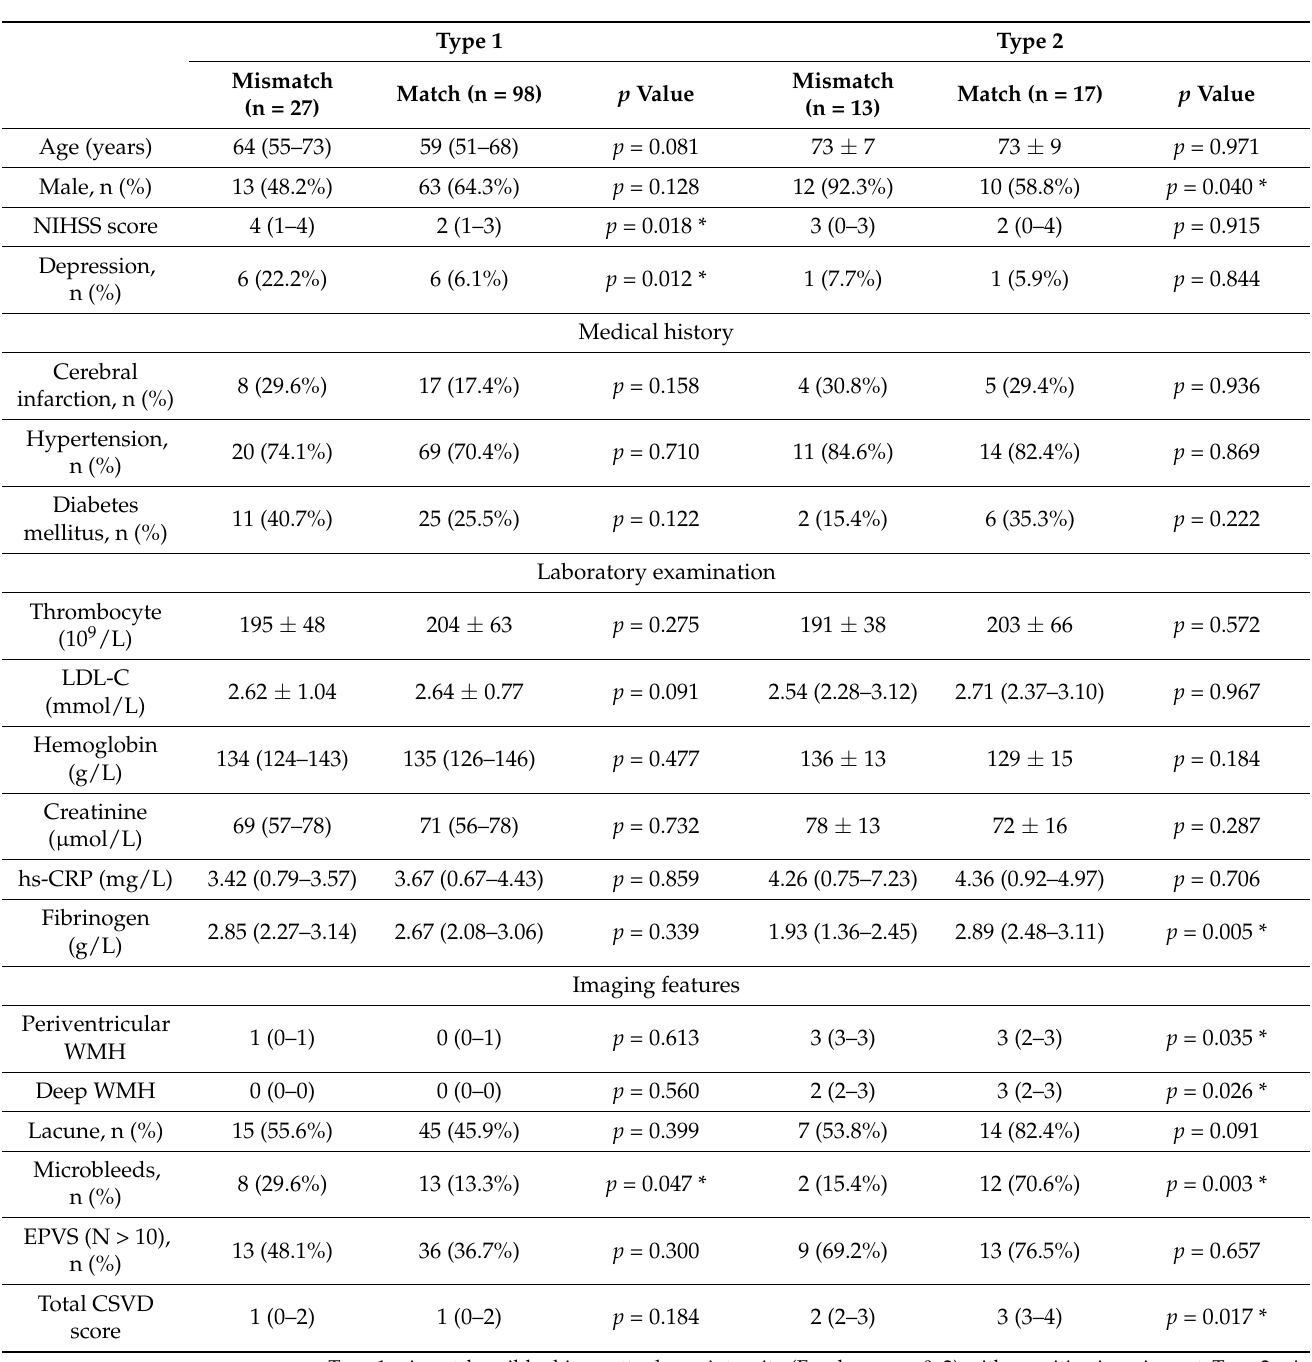
Table 4. Features related to Type 1 mismatch and Type 2